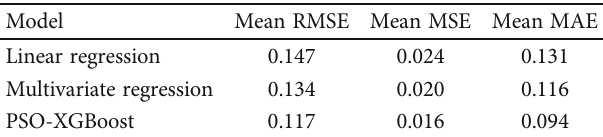
Figure 10: Comparison of the indicators of each machine learning model to predict permeability: (a) RMSE, (b) MSE, and (c) MAE. Table 4: PSO-XGBoost model and traditional permeability prediction model error index